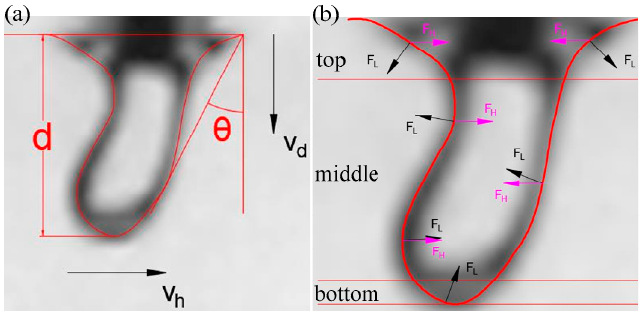
Figure 7. Bending keyhole: ( a ) Angle of bending keyhole; ( b ) Segmentation of bending keyhole.